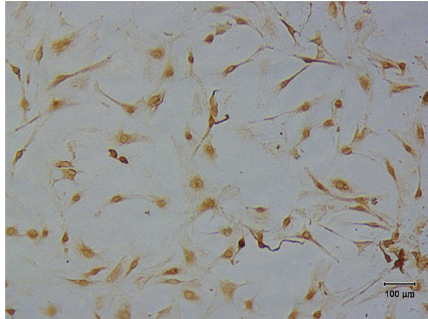
Figure 1: Identification of rat myoblasts. 𝛼 -actin was determined by immunohistochemistry (scale bar: 100 𝜇 m). Cytoplasm of rat myoblasts appears